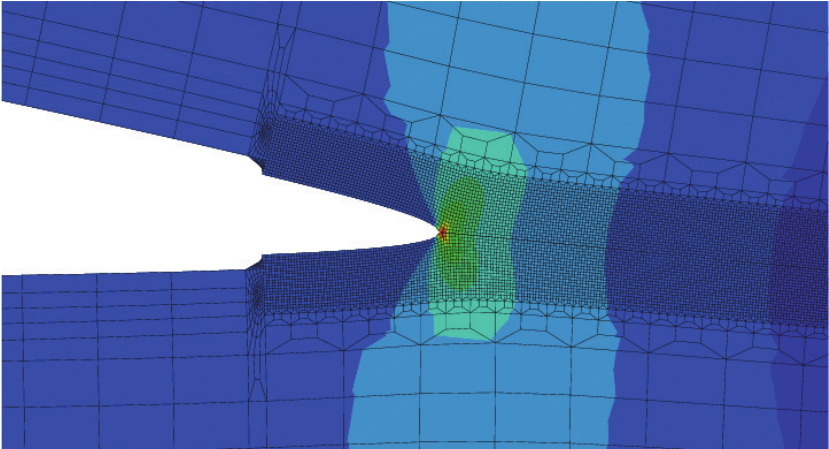
Figure 3: Stress contour ( 